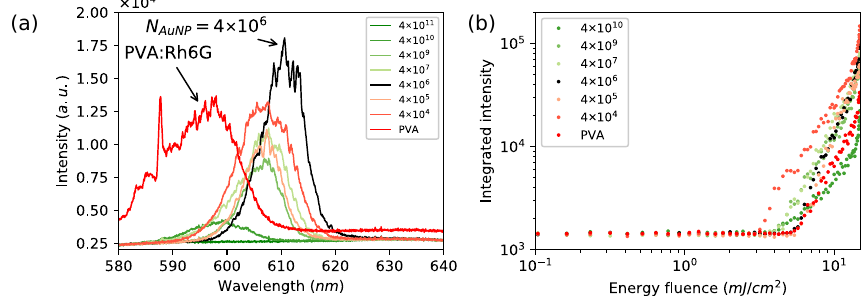
Figure 3. ( a ) random lasing spectra for PVA doped AuNPs and Rh6G. Lasing enhancement was observed for the total number of nanoparticles in the PVA layer equal to 4.0 × 10 6 particles; ( b ) integrated intensities as a function of energy density for lasing threshold determination.